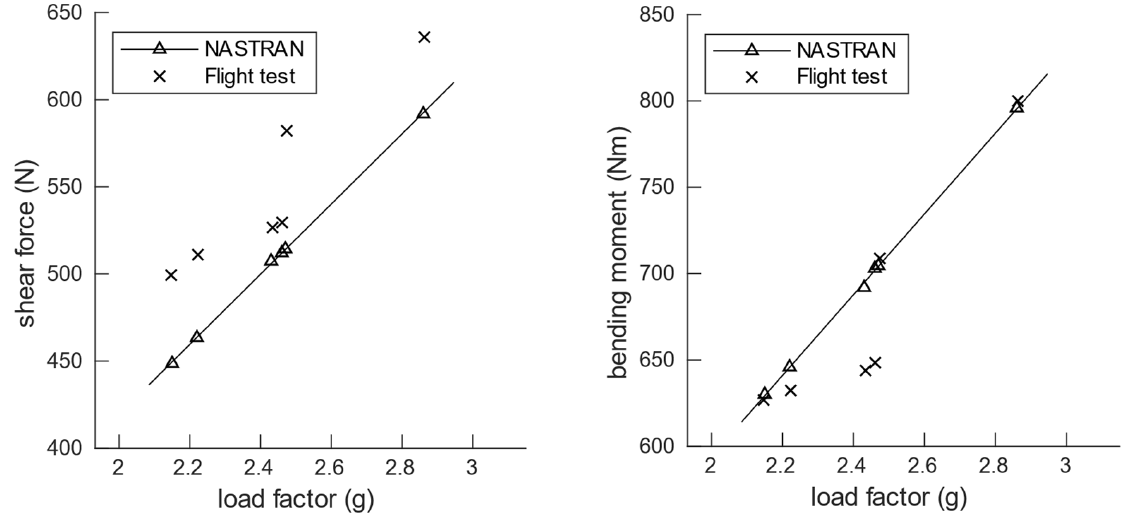
Figure 20. Shear force and bending moment (at wing root—span location 0.108 m) at different flight test manoeuvres for the tailored wing.